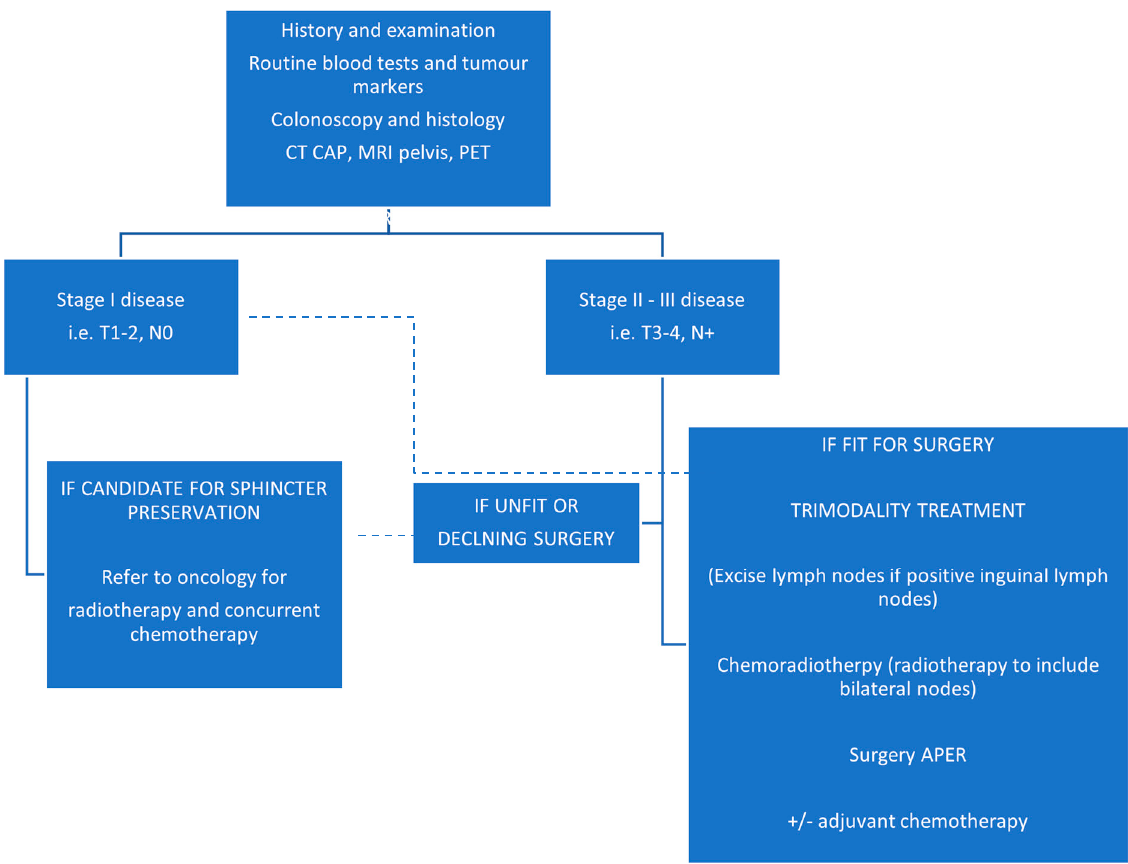
Figure 2. Overview of anal adenocarcinoma management (reproduced from Lukovic et al [6]).